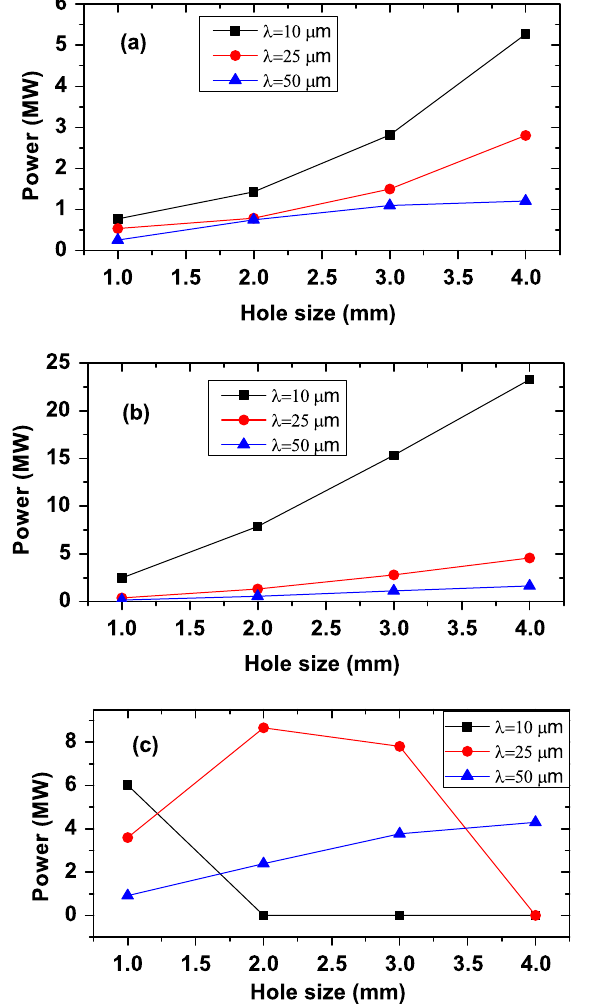
FIG. 11. Outcoupled power as a function of hole size at three different wavelengths for the (a) confocal ( g ¼ 0 ), (b) concentric ( g ¼ − 1 ) and (c) intermediate ( g ¼ − 0 . 6 ) configurations.